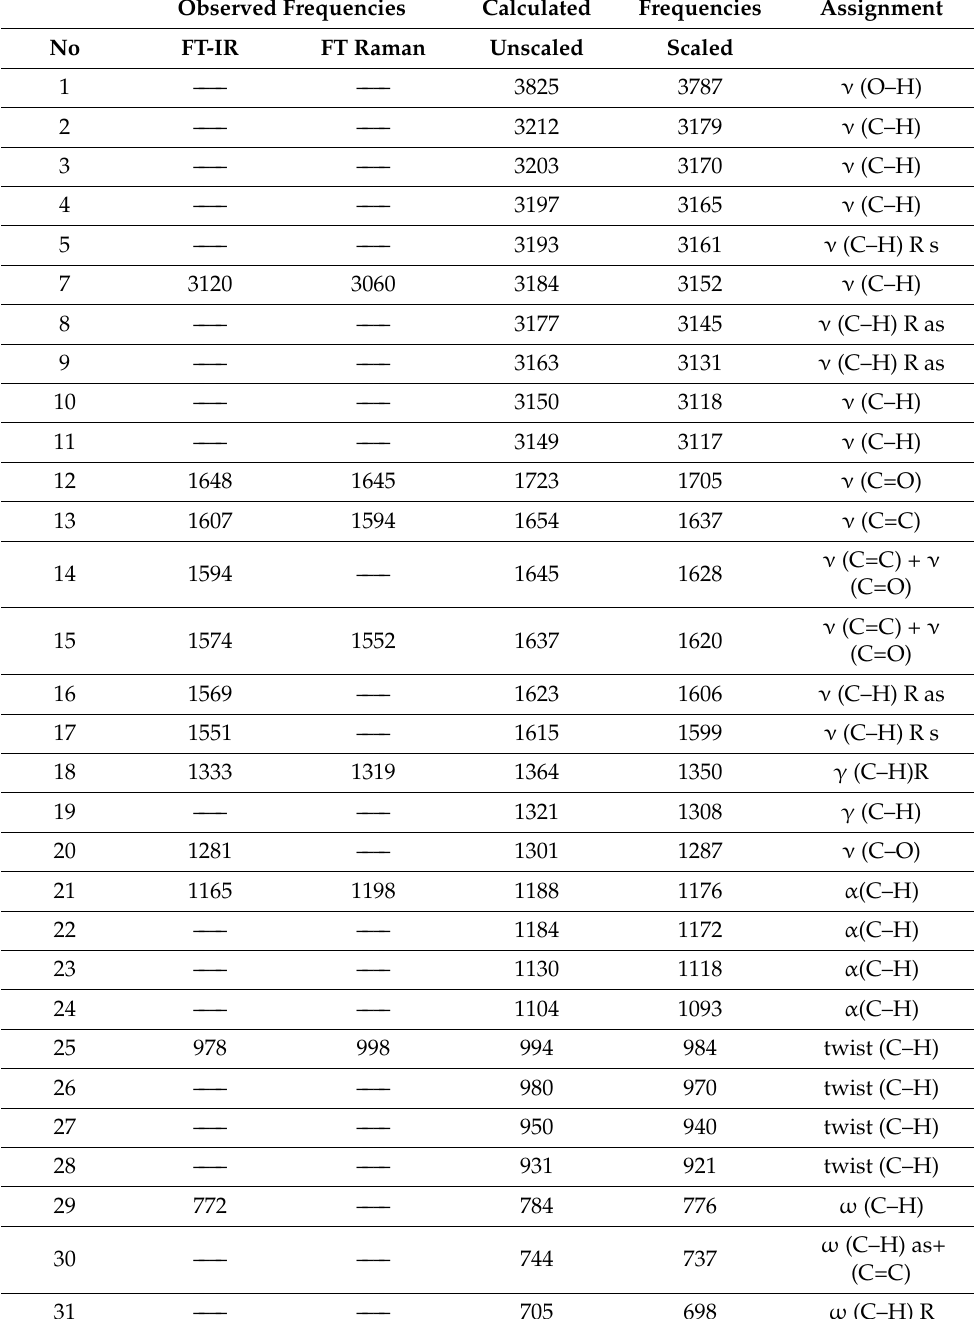
Table 1. Selected calculated and experimental FT-IR vibrational frequencies for 1-(4-Hydroxyphenyl)-